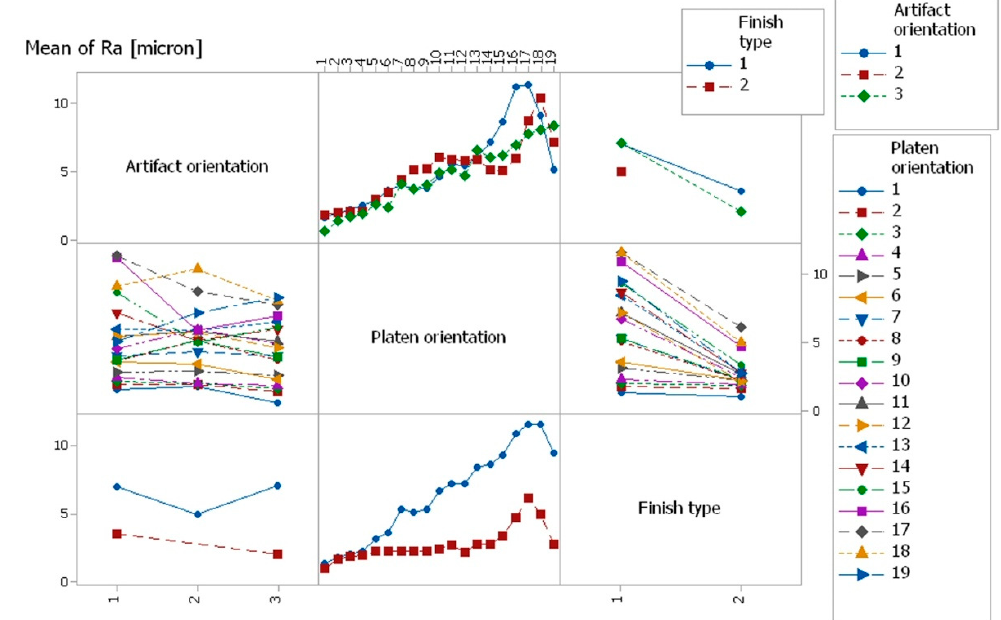
Figure 16. Interaction effects plot for surface roughness Ra.